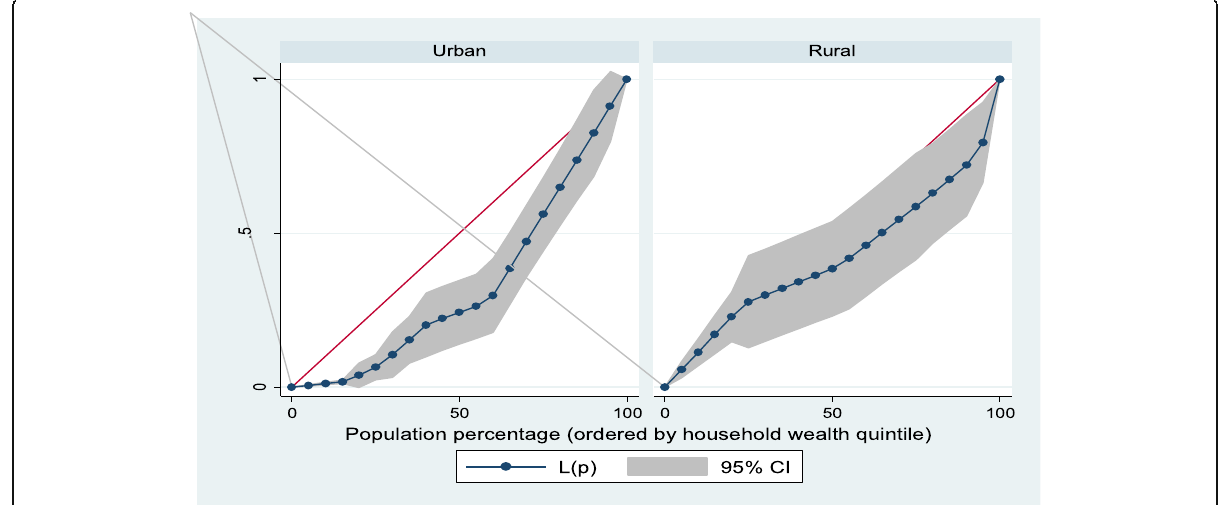
Fig. 1 Urban-rural differential in household wealth-related inequalities of ≥ 8 ANC contacts